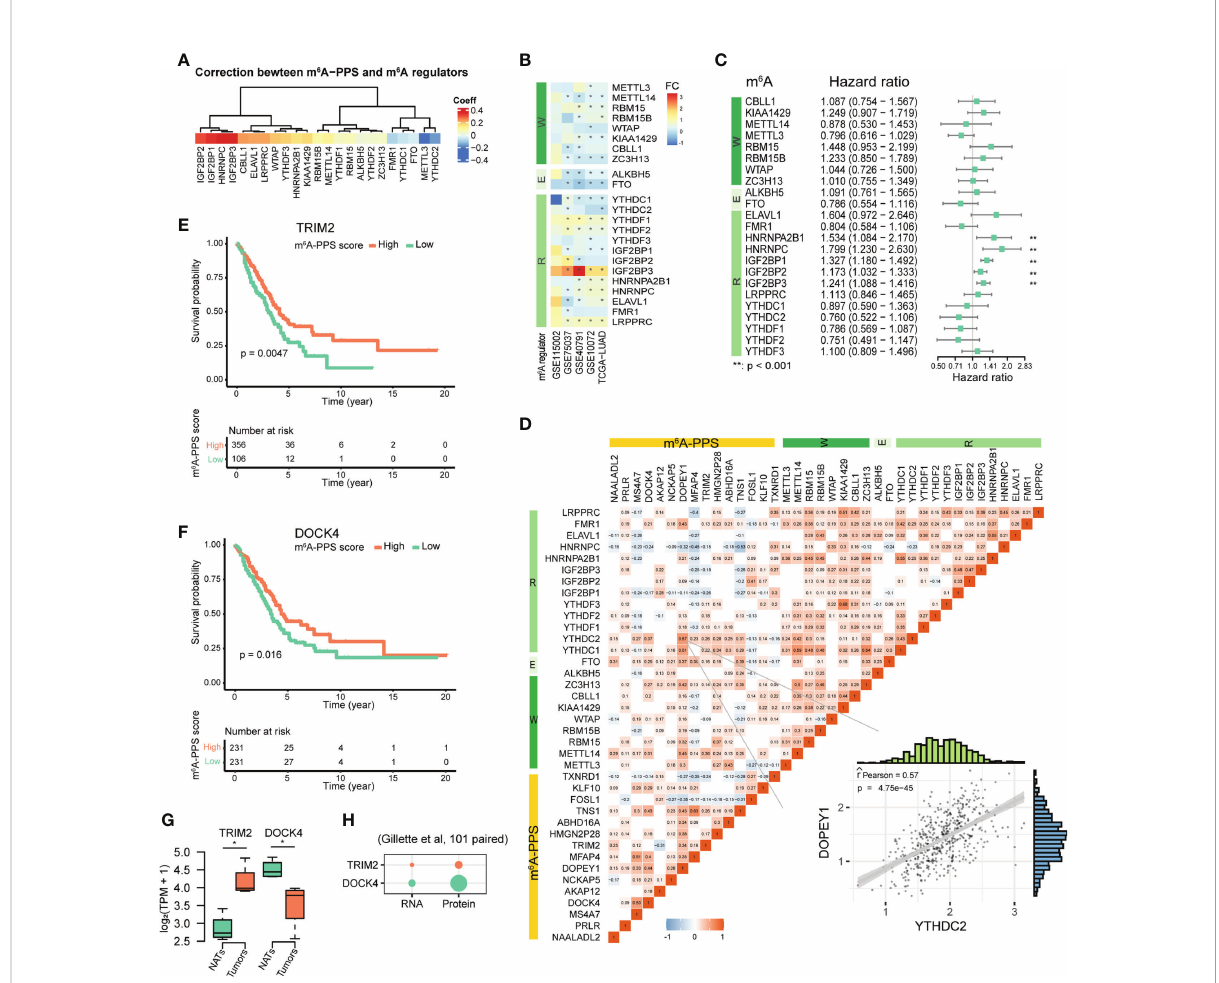
FIGURE 5 Molecular features of m 6 A-PPS and its correlation with m 6 A regulators. (A) Correlation between m 6 A-PPS and m 6 A regulators. (B) Heatmap showing the alternate expression of 23 m 6 A regulators across fi ve independent LUAD cohorts. The asterisk represents an adjusted P value< 0.05. FC denotes log 2 Fold change between tumor vs. normal. (C) Forest plot of the prognostic ability of 23 m 6 A regulators. (D) Heatmap for the correlations between 23 m 6 A regulators and 15 prognostic m 6 A-regulated genes in the TCGA-LUAD cohort. Scatterplot showing an example of the Pearson correlation between YTHDC2 and DOPEY1 (Pearson R = 0.57). (E, F) OS of LUAD patients strati fi ed by the expression levels of TRIM2 (E) and DOCK4 (F) . (G) Box plots showing the transcript-level differences of TRIM2 and DOCK4 in this study. (H) Dot plot depicting the differential expression of TRIM2 and DOCK4 at the RNA and protein levels in 101 tumors and 101 matched NATs. p-value from Wilcoxon rank- sum test